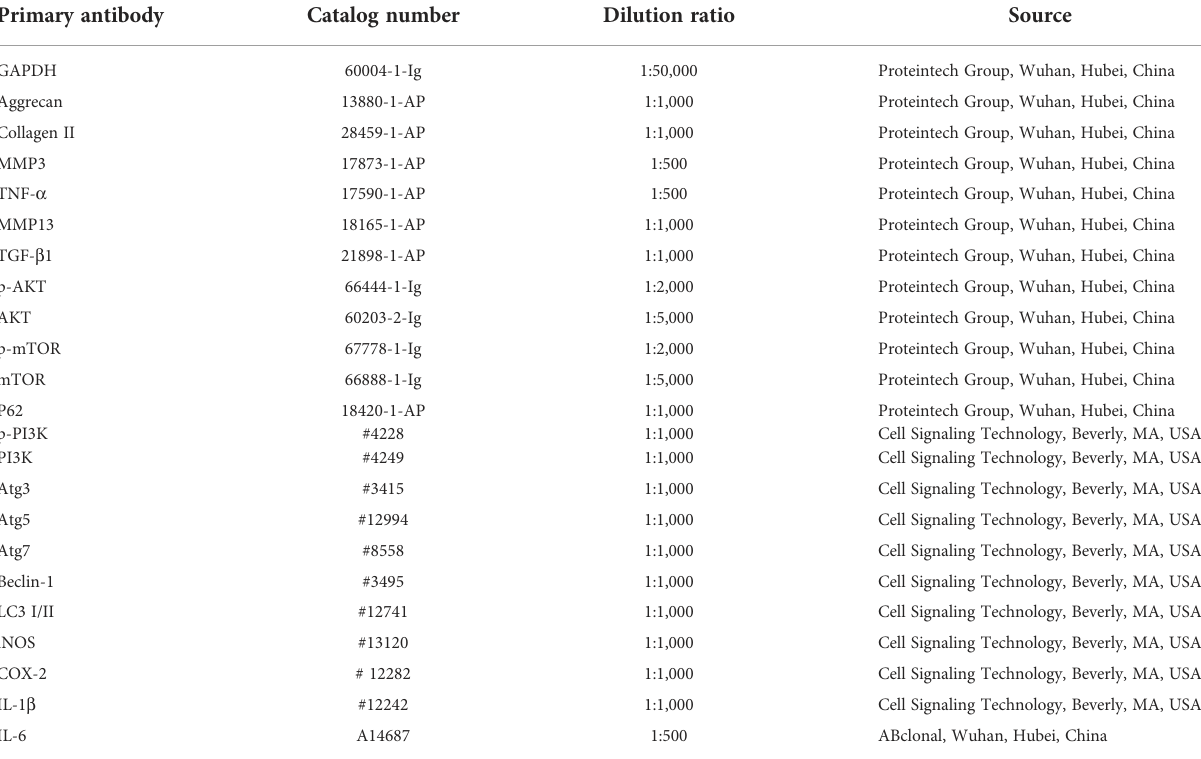
TABLE 1 Primary antibodies for western bolt. Primary antibody